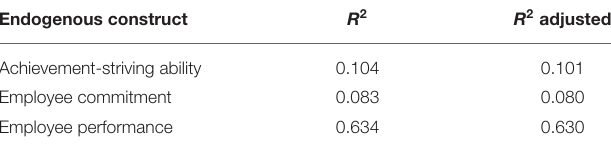
TABLE 5 | Coefficient of determination.